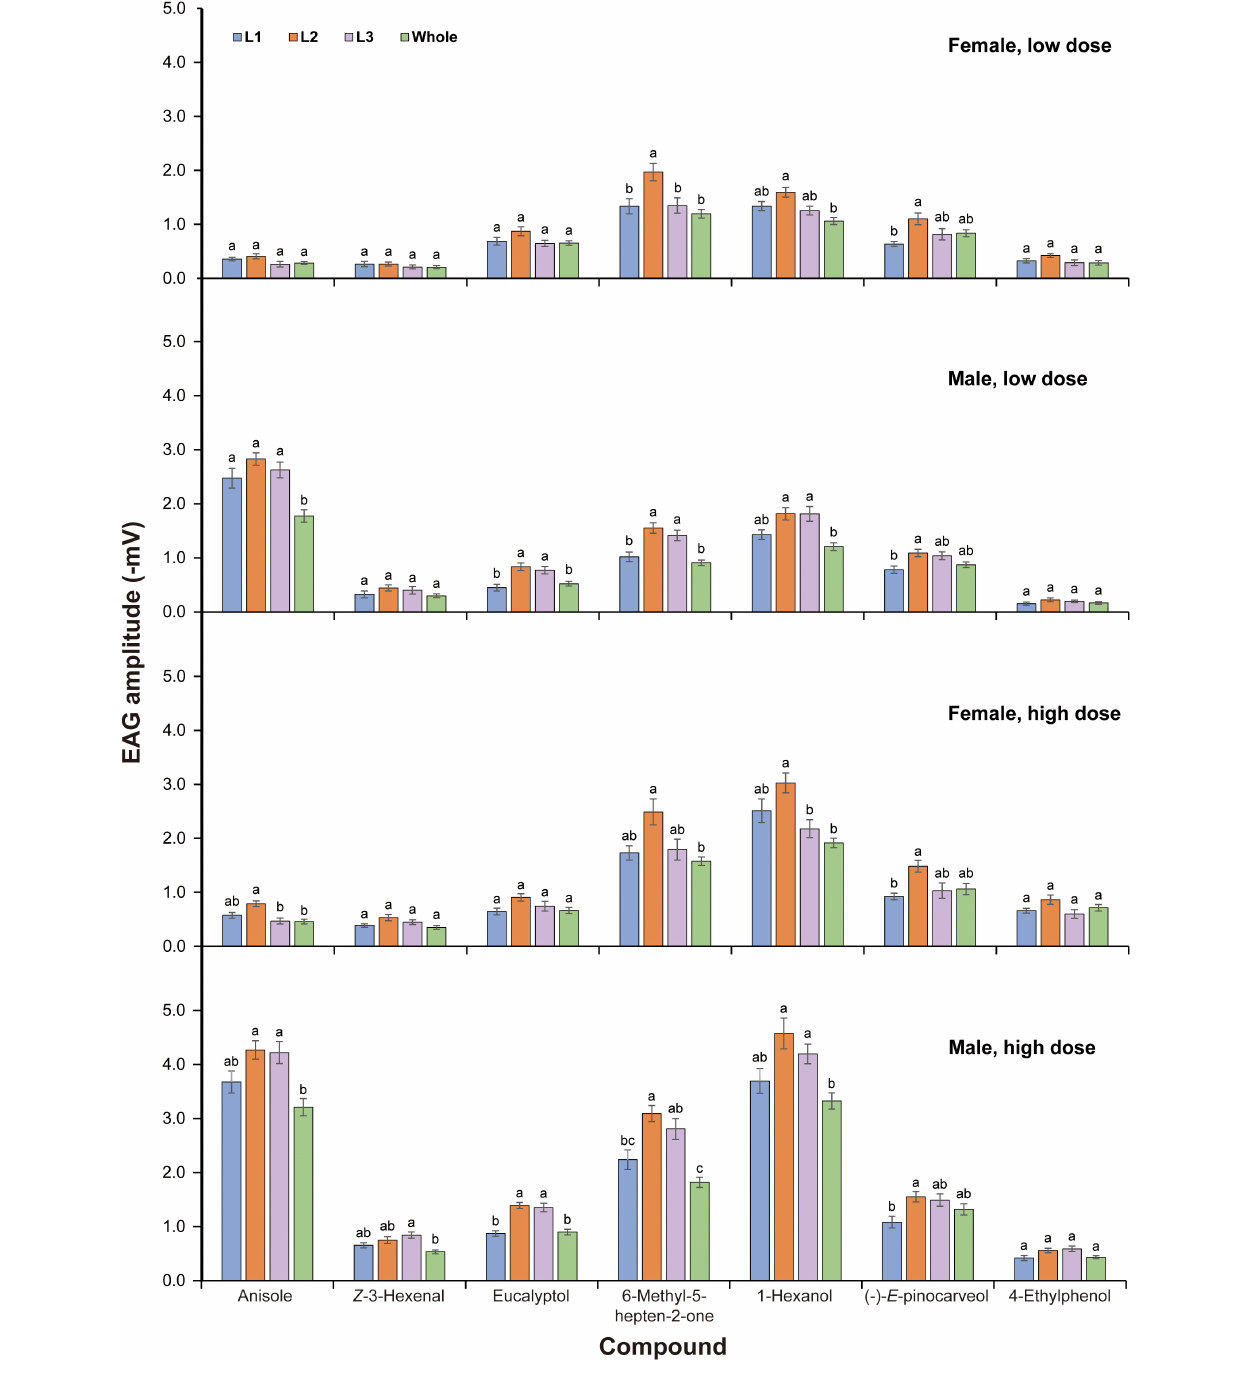
FIGURE 3 | EAG responses of antennae of Pseudosymmachia flavescens to synthetic volatile compounds. L1: proximal lamella; L2: mid lamella; L3: distal lamella; Whole: the closed club. Low dose: 0.1 µ g for anisole and 10 µ g for all plant volatile compounds; High dose: 1 µ g for anisole and 100 µ g for all plant volatile compounds. Columns with different lowercase letters are significantly different at P < 0.05 ( N = 10, Tukey tests after significant